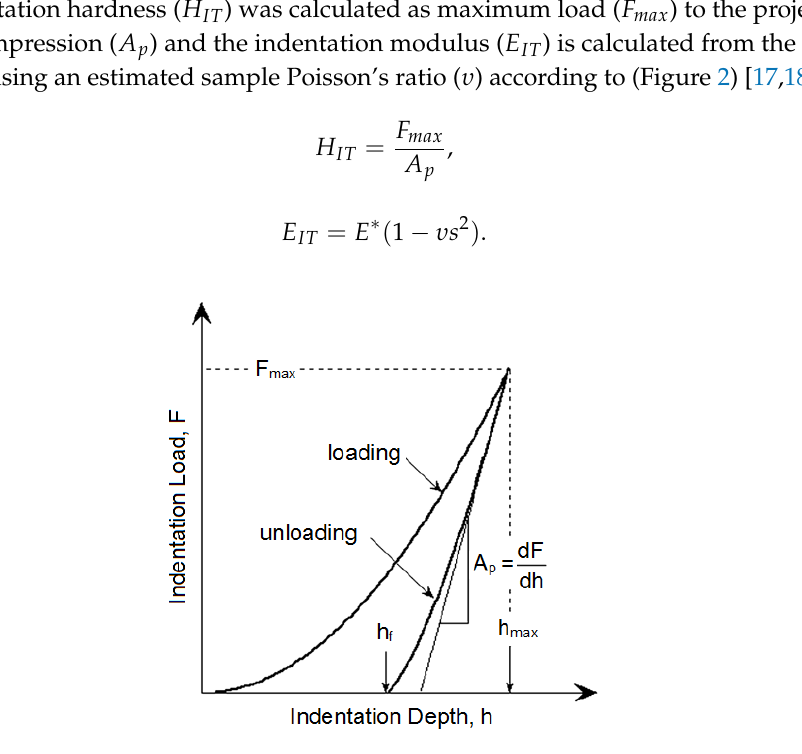
Figure 2. Schematic illustration of indentation curve